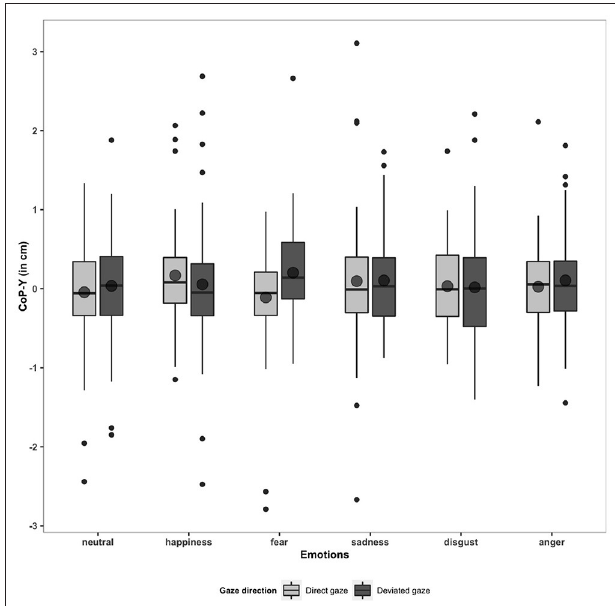
FIGURE 5 | Boxplots and means for CoP-Y (in cm) in response to six emotions (neutral, happiness, fear, sadness, disgust, and anger) and two gaze directions (direct and